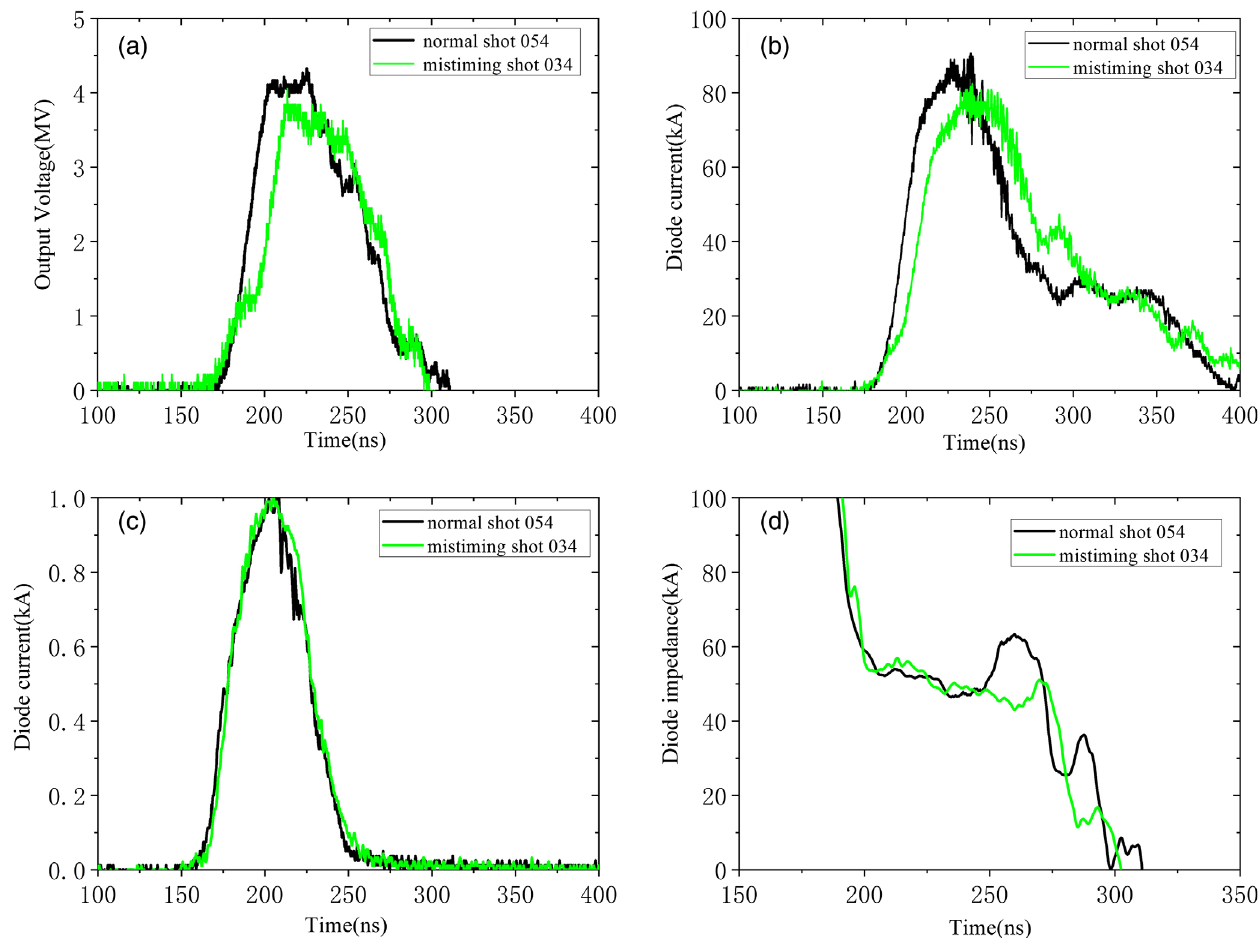
FIG. 13. Comparisons of electrical measurements from the mistiming shot 034 (green trace) and the normal shot 054 (black traces).